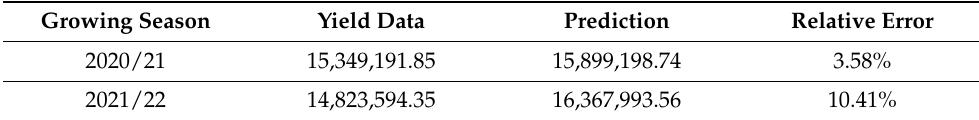
Table 7. Early prediction of crop data for Lahiguera district (Kg). Growing